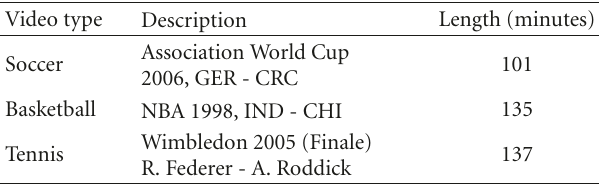
Table 1: Characteristics of the dataset. Table 2: Evaluation on event detection using entropy-based motion analysis.